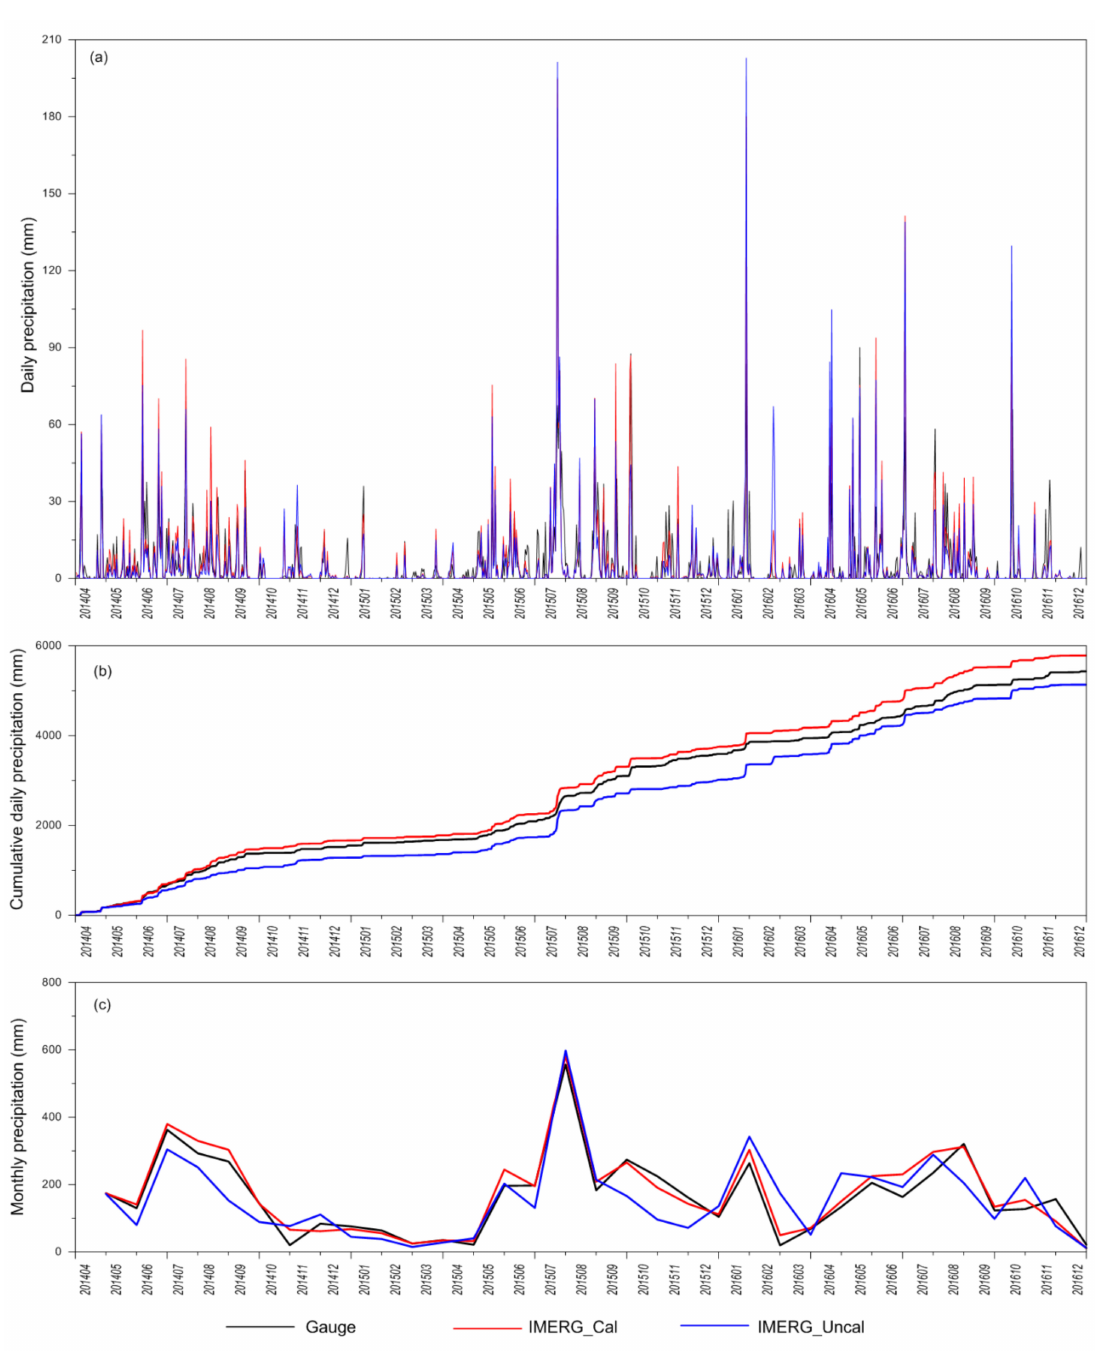
Figure 4. Time series of the basin-average daily precipitation ( a ), cumulative precipitation depths ( b ), and monthly precipitation ( c ), over the Nanliu River basin from gauges and the IMERG, from April 2014 to December